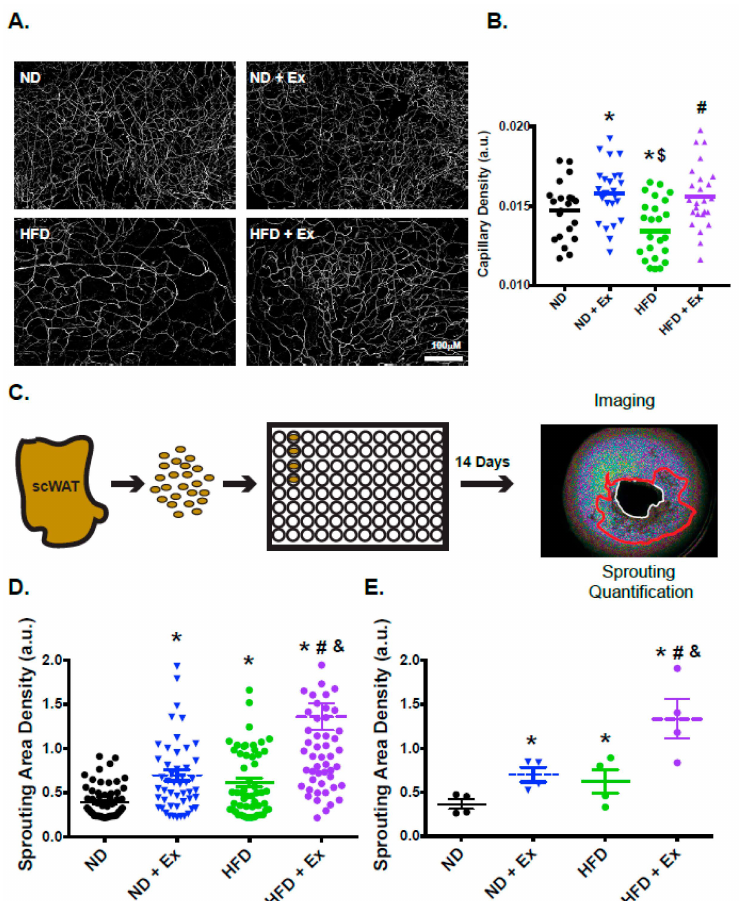
Figure 4. Exercise improves vascular density and increases angiogenic capacity in scWAT. ( A ): Maximal intensity projections of 25 epiflourescent images acquired at 10- µ m intervals (250- µ m thickness) of isolectin B4 stained fragments of scWAT from mice fed ND (top left panel), ND + Ex (top right panel) HFD (bottom left panel) or HFD + Ex (Bottom right panel). ( B ): Data from the micrographs was quantified demonstrating vascular density in the scWAT depots. (5 sections / mouse; N = 5 mice / group). ( C ): An angiogenesis sprouting assay was used to measure sprouting (angiogenic) capacity. scWAT depots were carefully dissected and cut into 1mm segments. These segments were then plated in a 96-well matrigel coated plates and after 14 days of growth, imaged and sprouting was quantified. A representative image of explant out-growth (circled in red) is shown on the right. ( D ): Angiogenic capacity ((number of sprouts / explant)(% of explants sprouting)) of explants derived from mice fed ND, ND + Ex, HFD, HFD + Ex. Angiogenesis was quantified as area of outgrowth. ( E ): Summary data is shown for each mouse. ( > 25 segments / mouse were assessed and 4–5 mice / group measured (* p < 0.05 vs. ND; # p < 0.05 vs. HFD; & p < 0.05 vs. ND +